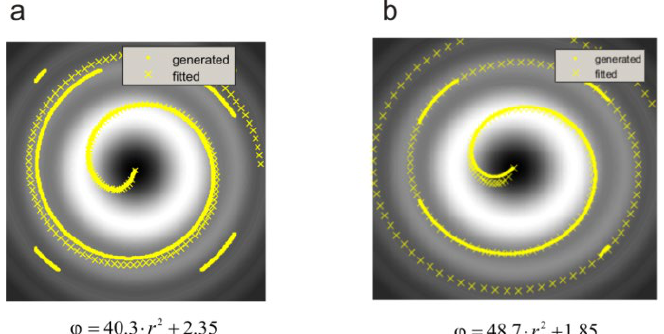
Figure 7. Numerical phase profile of the spiral beam created by the spiral phase plate plotted on the background of the intensity distribution. Spiral line can be described by two Fermat’s spirals. ( a ) One spiral fitting to the central area of the beam; ( b ) A second spiral fitting to the external areas of the beam. Recovered spiral equations are also provided.